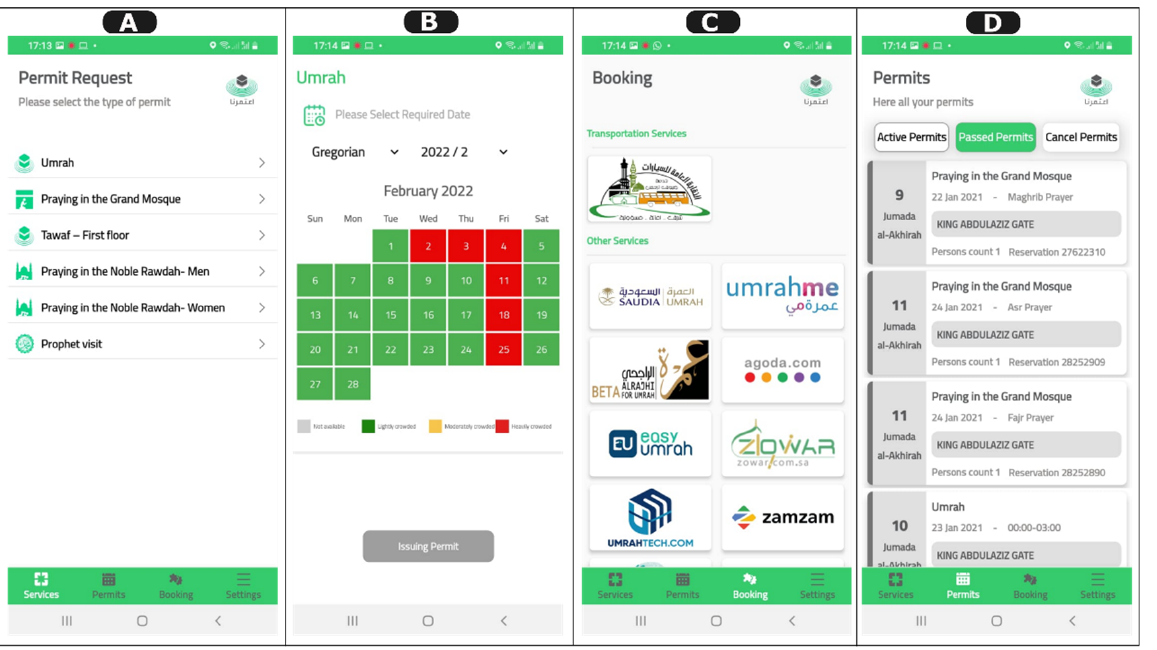
Figure 2. Eatmarna application interfaces for permit requests ( A ), date selection ( B ), booking of additional requests ( C ) and tracking the permit statuses ( D ).